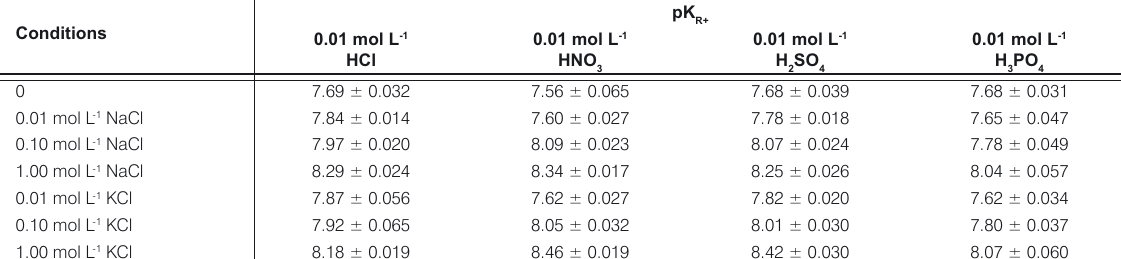
Figure 4. pK values of sanguinarine in dependence on a type and concentration of inert electrolyte (ionic strength) in the presence of NaCl (right) R+ or KCl (left). Experimental conditions: 1 – 10 mmol L -1 HCl, 2 – 10 mmol L -1 HNO Table 5. Influence of ionic strength (NaCl and KCl as inert electrolytes) on pK